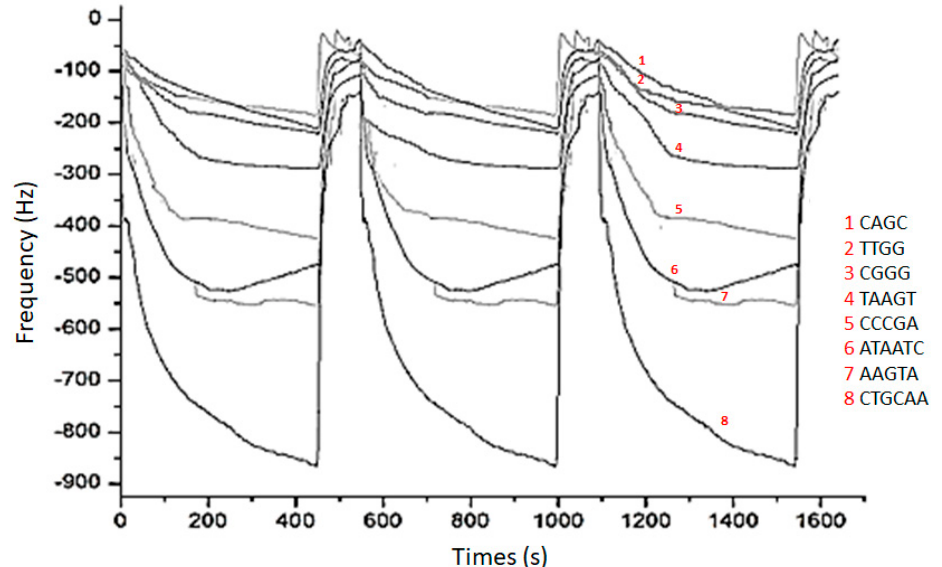
Figure 3. Frequency signal recorded with gold nanoparticles / hairpin-DNA (AuNPs-hpDNA) array (three repetitions performed on the same sample).